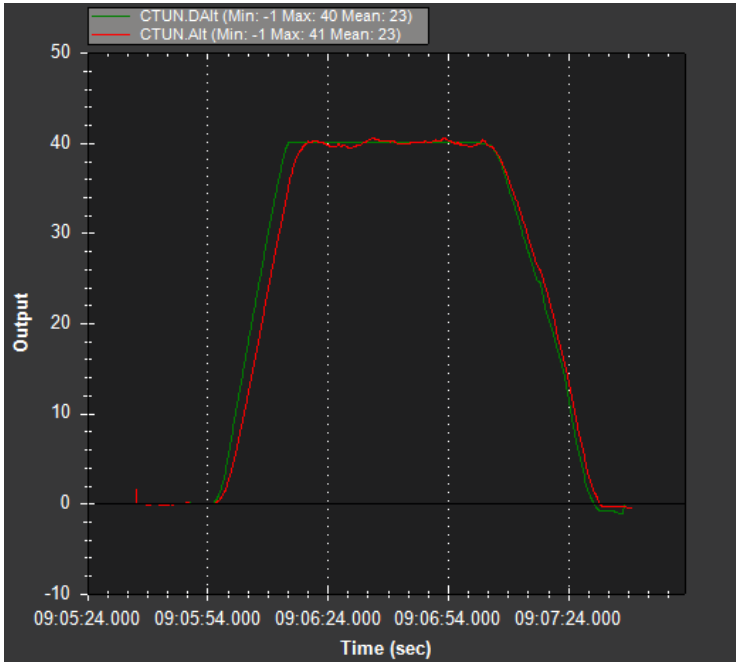
Figure 21. The difference between desired and actual altitude of drone, green line—desired altitude, red line—actual altitude.